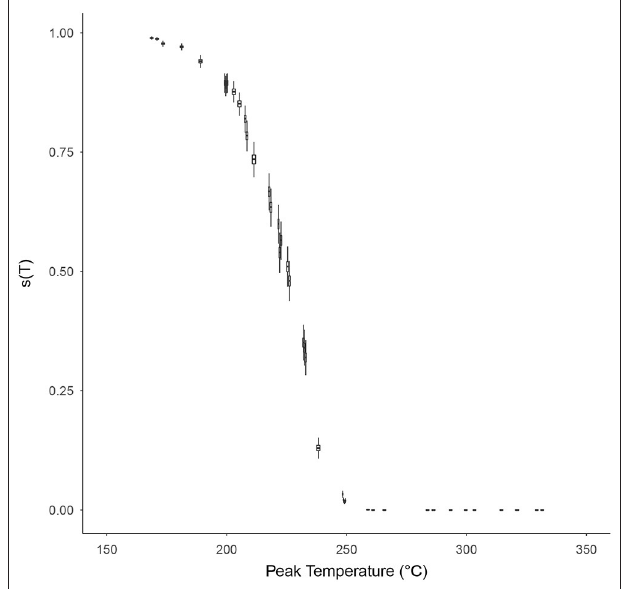
FIGURE 6 | The probability of individual microorganism survival, s ( T ) (vertical axes), with respect to the peak temperature of the time-temperature profile, T (horizontal axes), for each survival ratio experiment, based on Equation (10). Box and whiskers show 50 and 95% credibility intervals, respectively, while horizontal lines accompanying each box-whisker show the mean